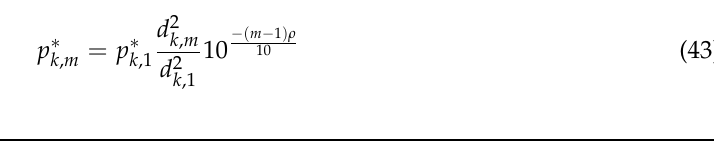
Algorithm 4 The algorithm for solving problem